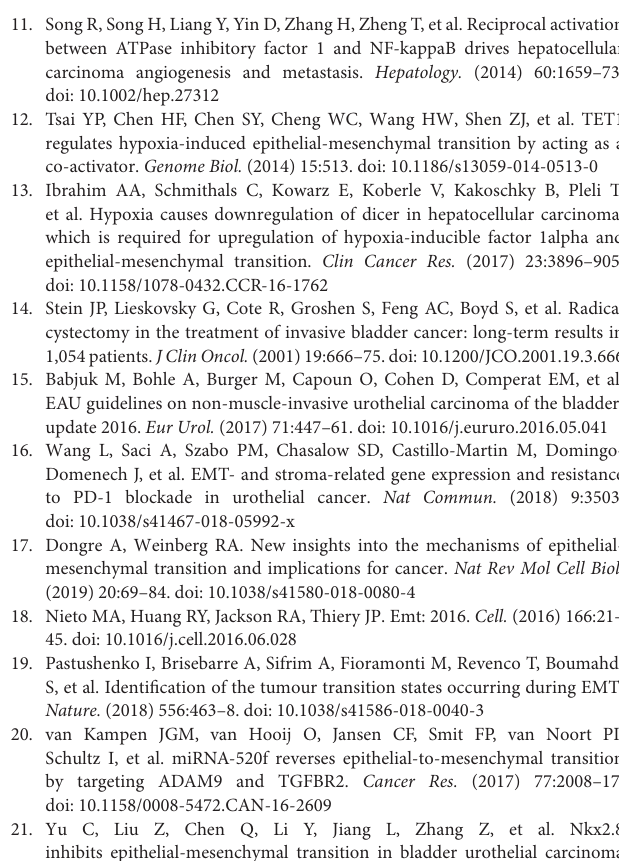
Supplementary Figure 1 | (A) The expression of CORO1C and TMPRSS4 in normal bladder tissues and bladder cancer tissues in the TCGA and GTEx database. (B) The relationship between two hub genes and tumor stage via GEPIA online